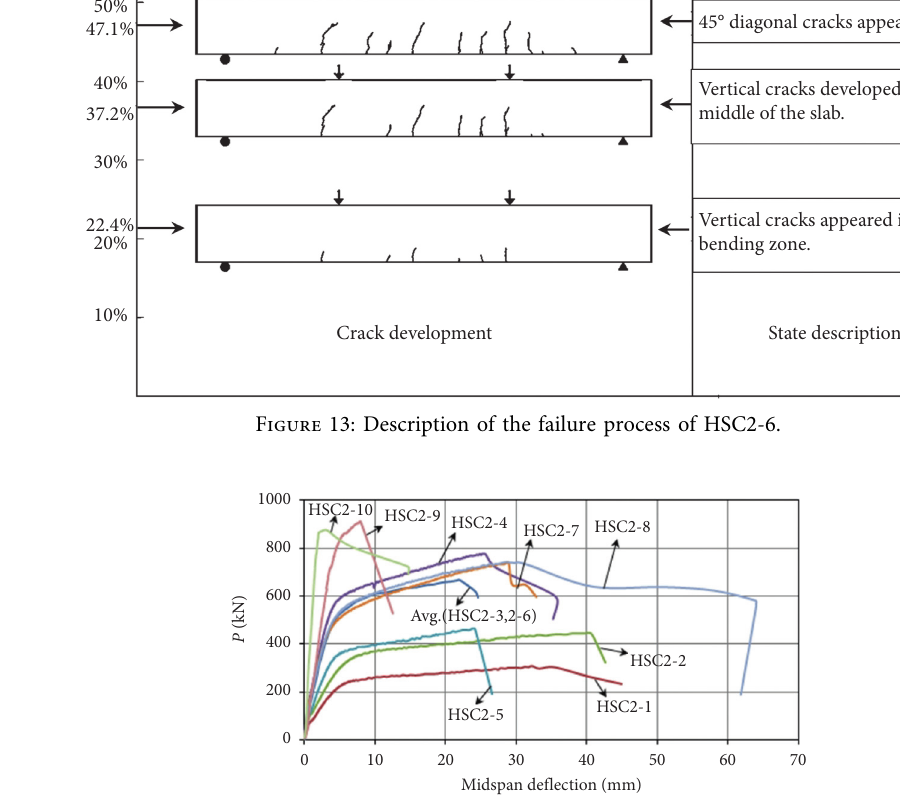
Figure 14: Load versus midspan deflection